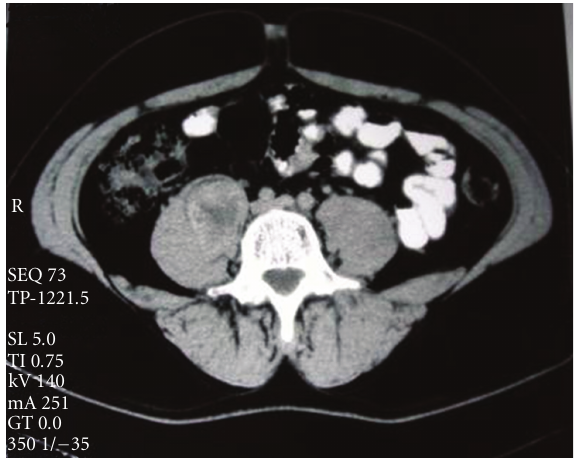
Figure 3: Metastatic lesion of the right iliopsoas muscle.